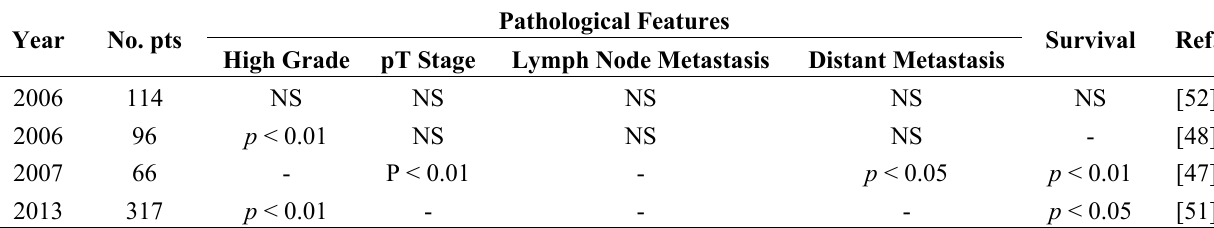
Table 3. Relationship between MET expression and grade, tumor stage, and prognosis for patients with renal cell